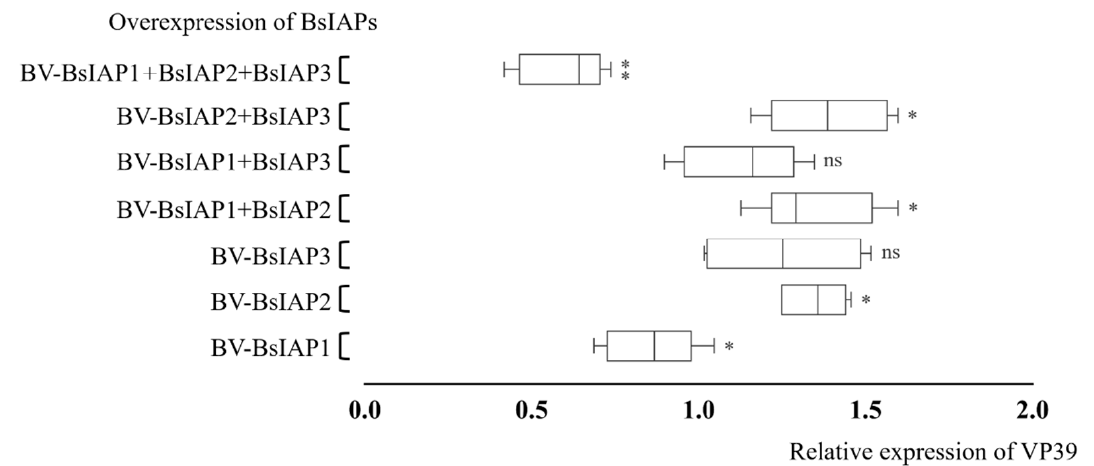
Figure 8. Effects of BsIAP overexpression on VP39 capsid protein levels. * p < 0.05, ** p < 0.01. After 48 h of infection with recombinant baculovirus stably expressing BsIAPs, total RNA was extracted, and the expression of vp39 gene was determined by reverse transcription PCR. The VP39 expression is relative to the control group (baculovirus AcBV-gfp expressing fluorescent protein only).